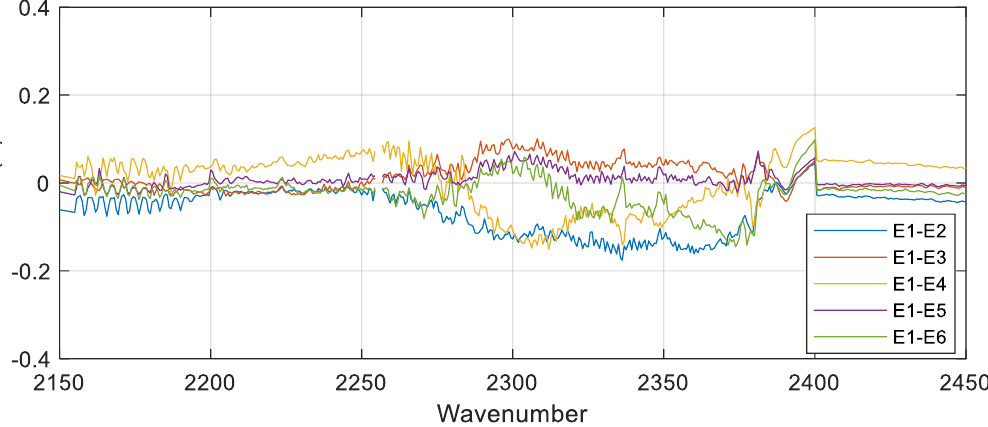
Figure 16. Evaluation of precision of COSMIC-2 through deriving spectral BT biases between COSMIC-2 E1 and five other COSMIC-2 sensors by using CrIS as the reference sensor in the double- difference method.